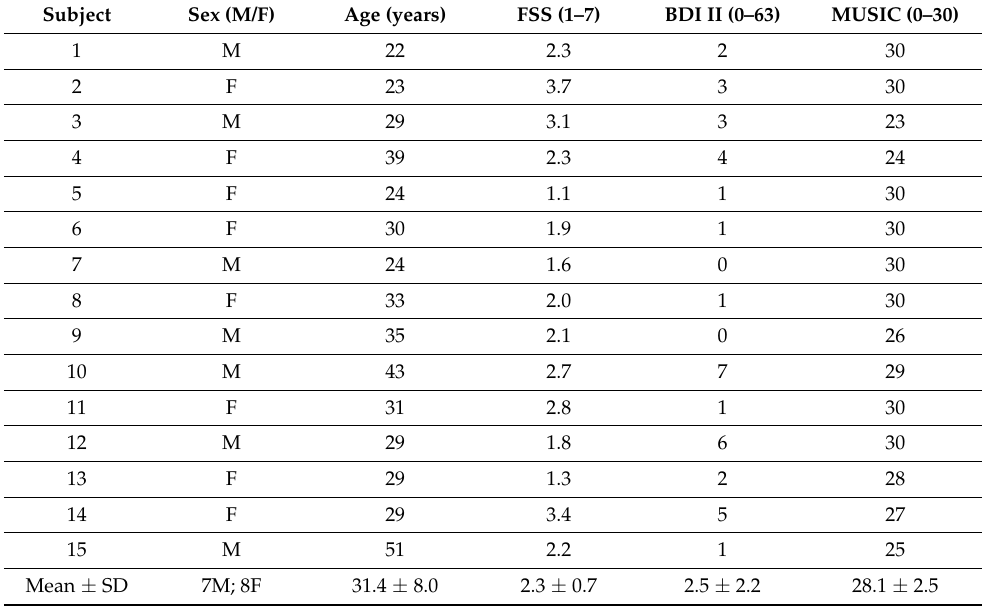
Table 2. Healthy control characteristics.